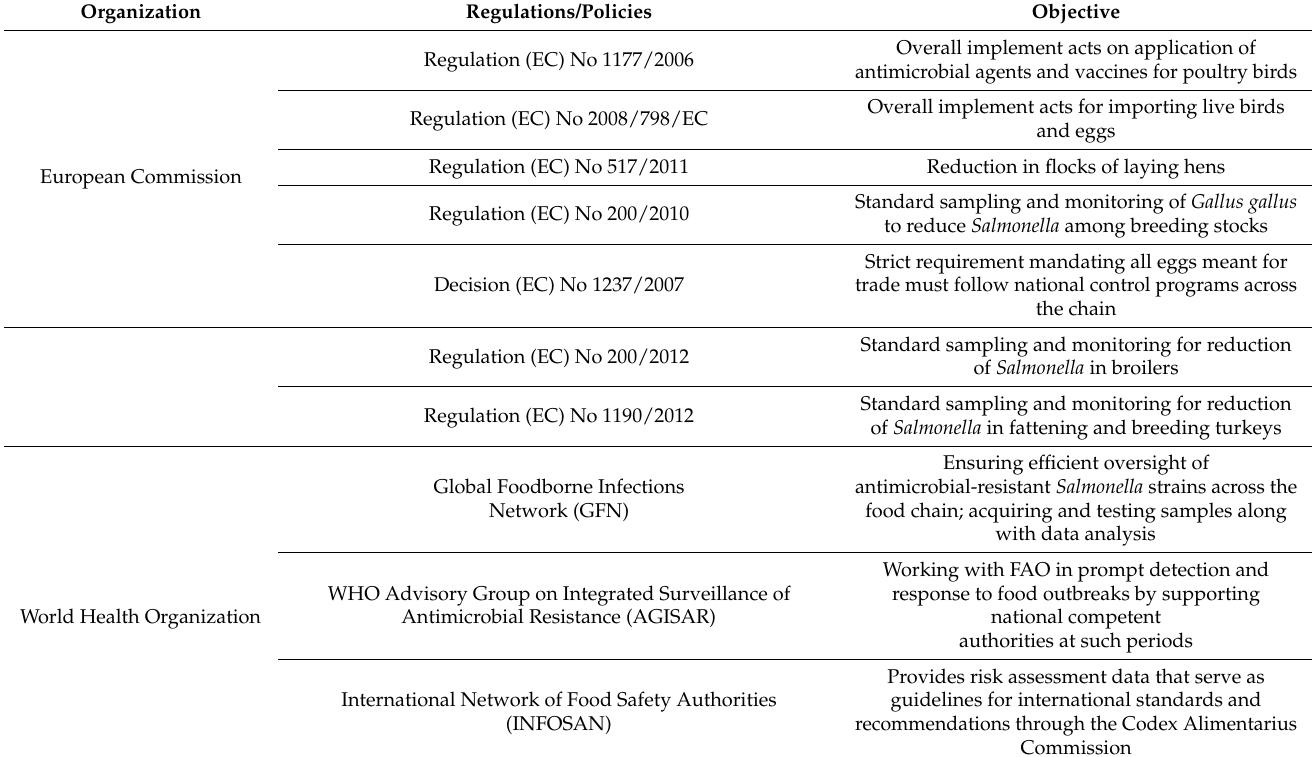
Table 6. Legislations and Policies against